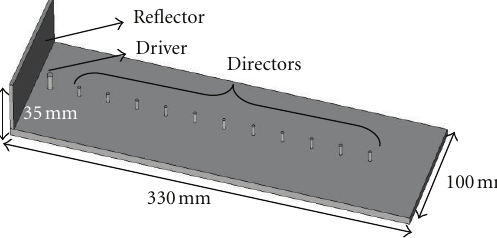
Figure 18: Proposed Yagi